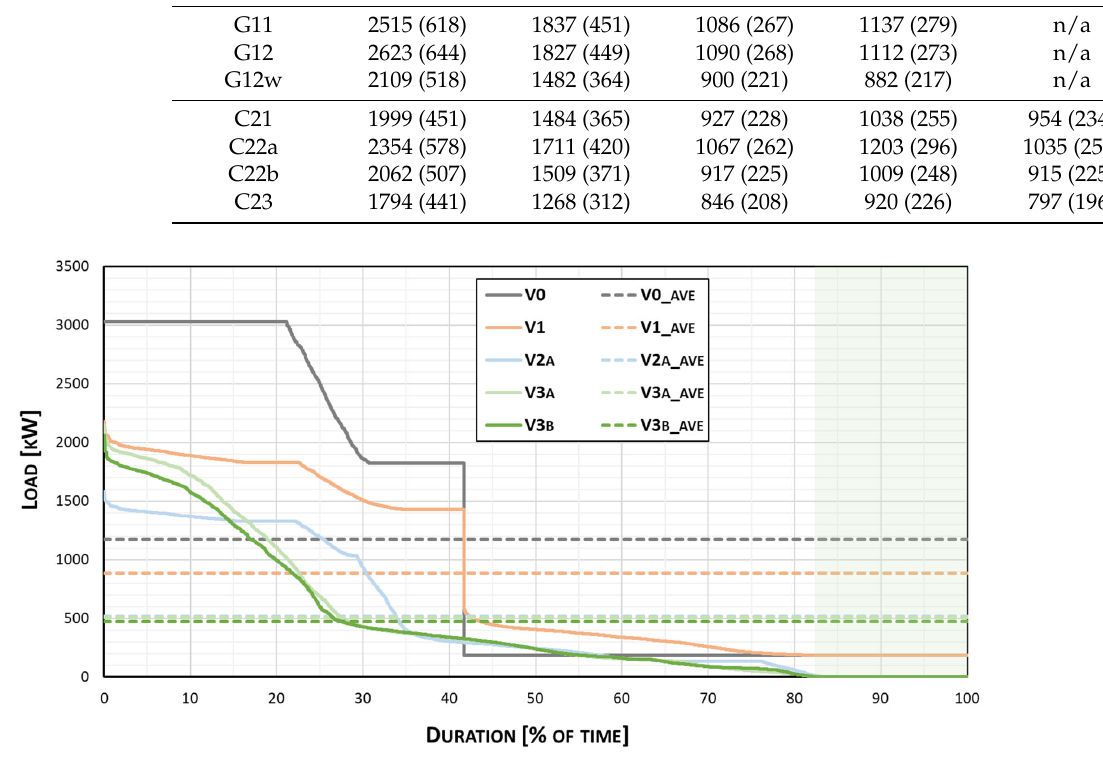
Figure 9. Electricity LDCs for the Nowosolna